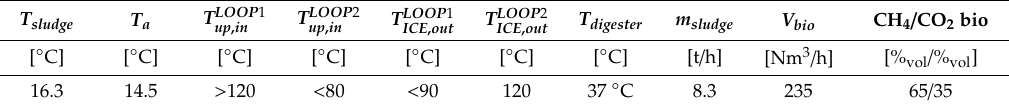
Table 2. Boundary conditions used in the